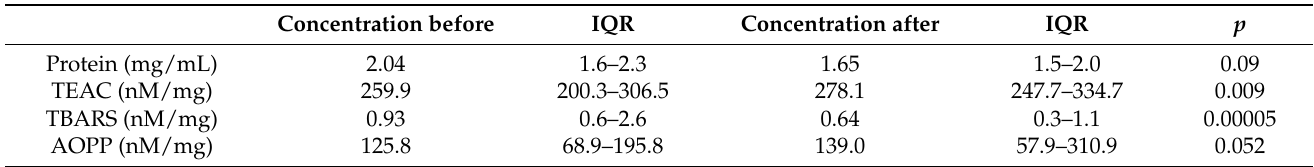
Table 5. Concentration of selected oxidative stress indicators in saliva before and after the application of the toothpaste. Median (IQR). The Wilcoxon signed-rank